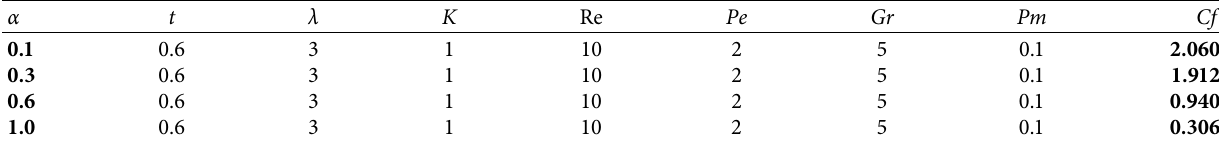
Table 2: Variation in skin friction for diferent values of α